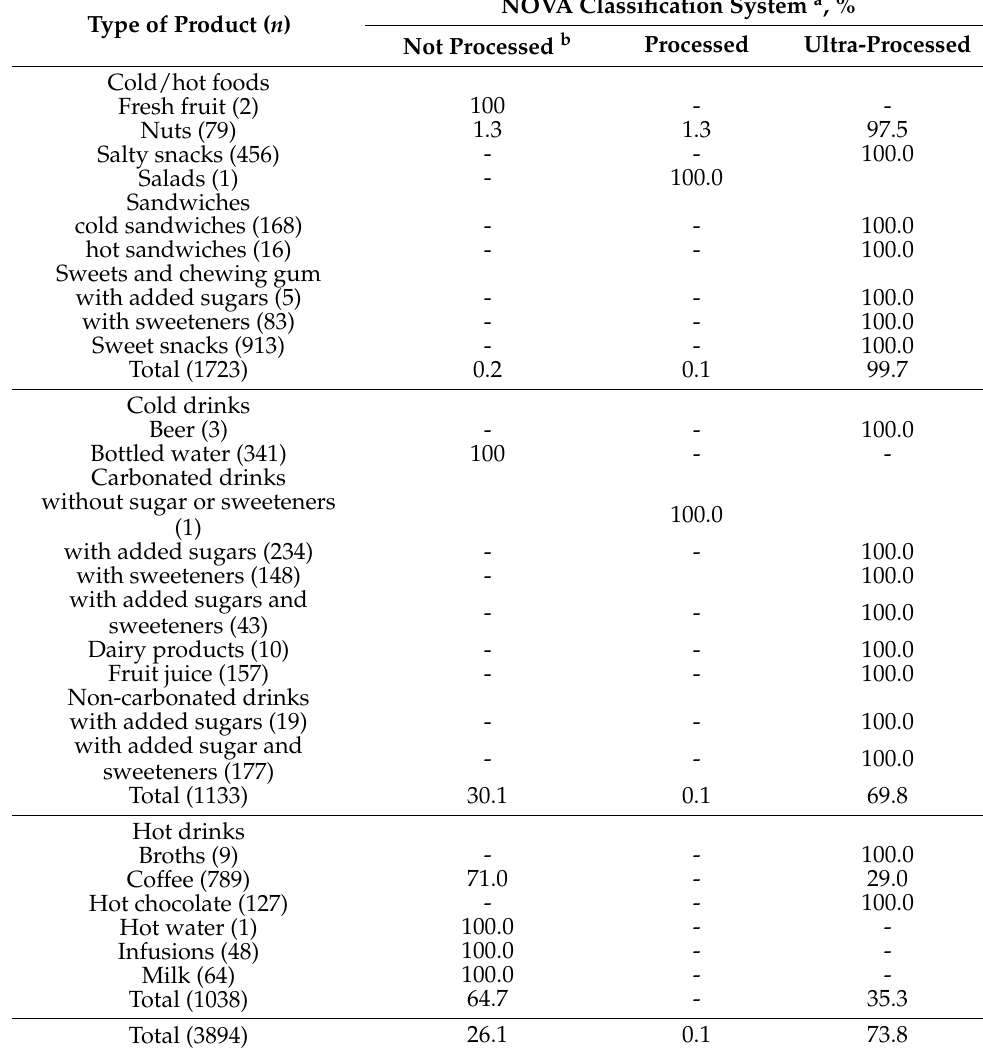
Table 3. Processing levels of products offered in food and drink vending machines at the University of the Basque Country (Spain).